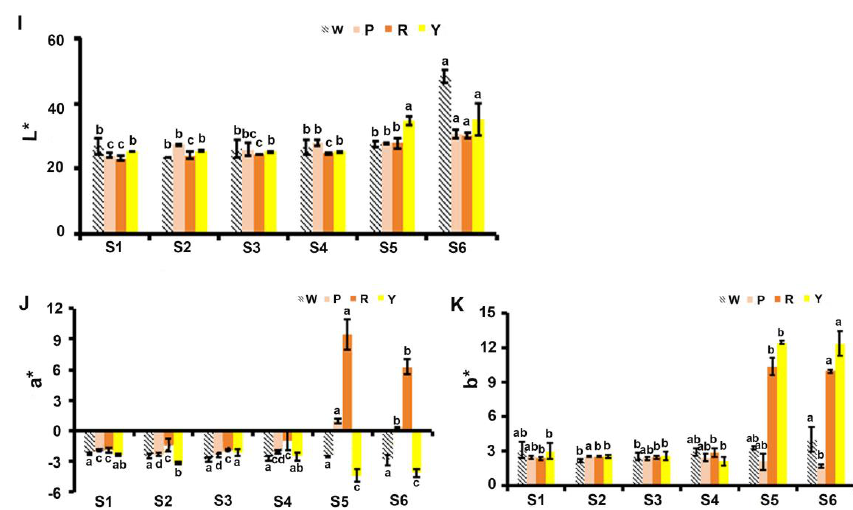
Figure 1. The four colored chrysanthemums and their six stages during the flowering period. ( A – D ) The picture of potted white, pink, red, and yellow chrysanthemums. ( E – H ) The six flowering stages of white, pink, red, and yellow chrysanthemums. ( I ) Measurement of lightness (L*) of ray florets of four colored chrysanthemums during the flowering period. ( J ) Measurement of chromatic components a* and b* ( K ) of ray florets of four colored chrysanthemums during flowering period. Bar = 1 cm. Note: In ( I , J , D ), data are shown as the mean ± standard error of the mean, based on more than five replicates. Different alphabets indicate significant differences at p < 0.05 according to the Duncan’s multiple range test.